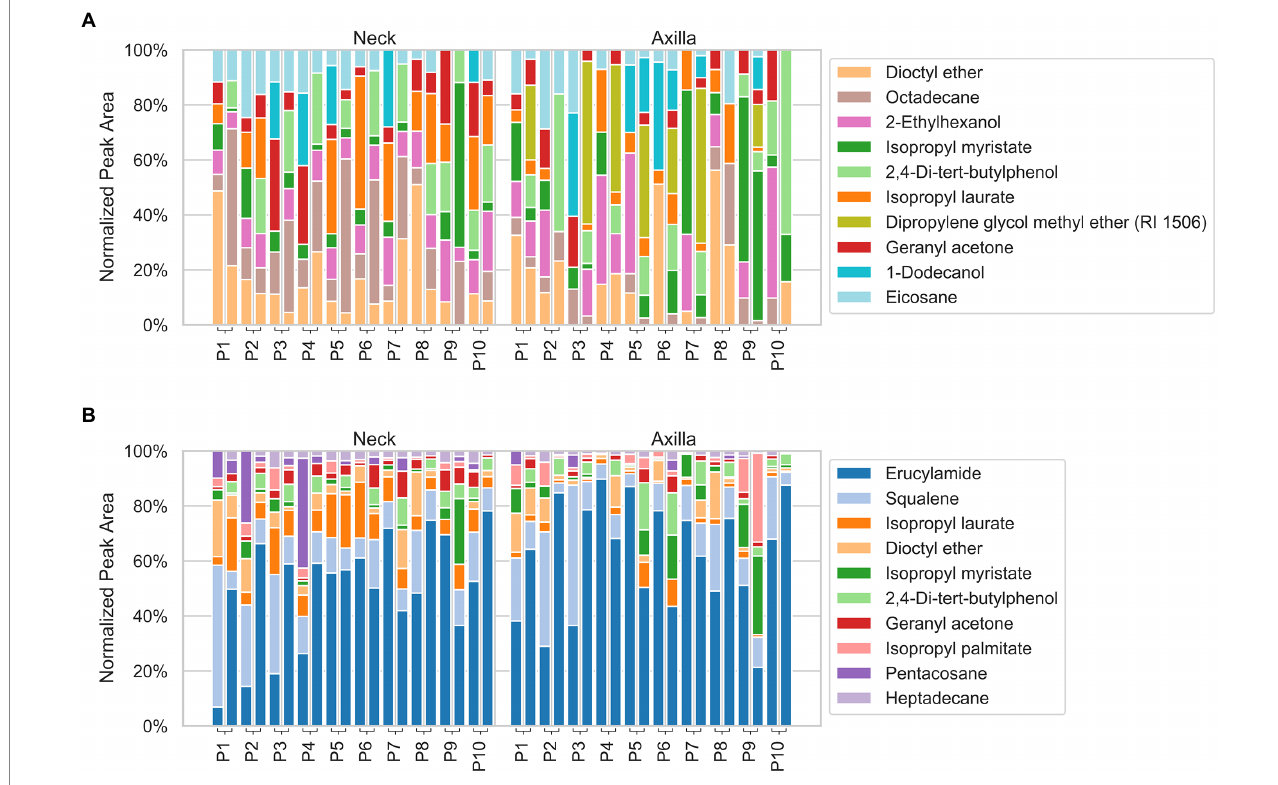
FIGURE 3 Stacked bar plots of volatiles detected by using a FFAP (A) and DB-5 (B) analytical column, showing the normalized relative peak area of the ten most abundant volatiles in the neck (left) and axilla (right) samples. The difference of sampling day 1 and 2 is represented by the two stacked bar plots connected to each participant. Note that only the ten most abundant volatiles are shown and the relative/normalized abundance on the y-axis is given with respect to those ten only (i.e., 100% abundance refers to the top ten and not to all volatiles found for the respective